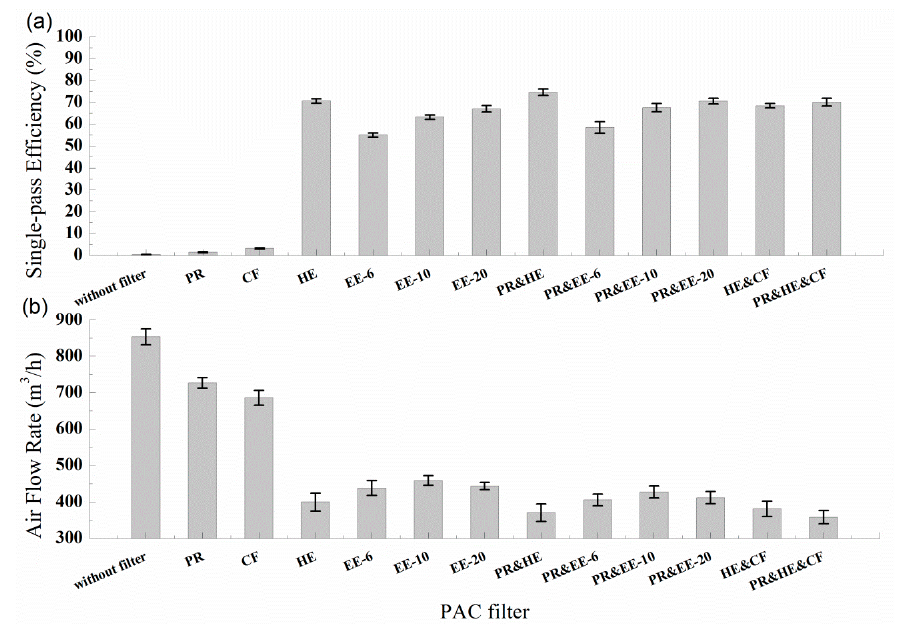
Figure 8. Single-pass efficiency and airflow rate of PACs with different filters. ( a ) Single-pass Efficiency; ( b ) Air Flow Rate.